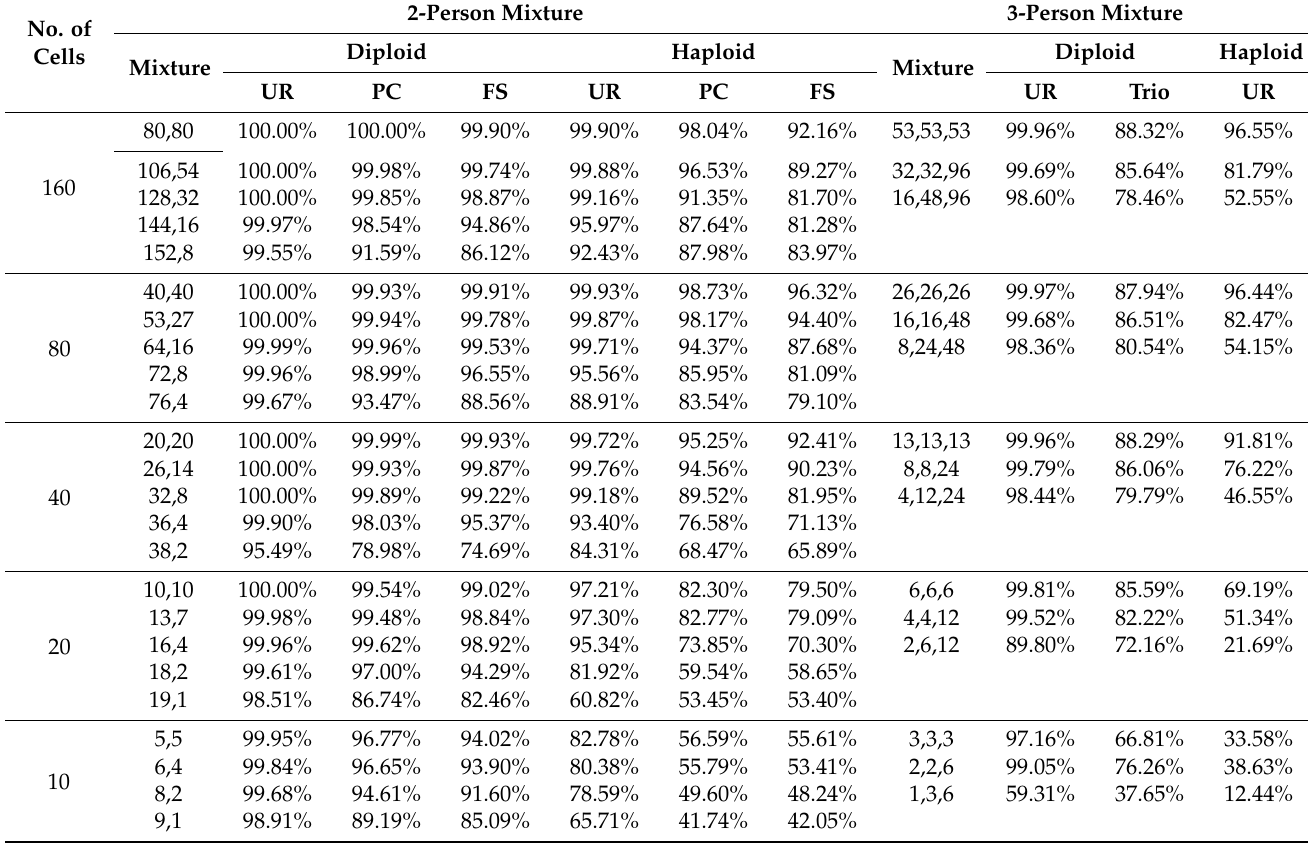
Table 1. Accuracies of estimating the NOC with the EM algorithm and Silhouettes method for the various mixture scenarios. UR = unrelated, PC = parent-child, and FS = full-sibling. D = 0.2; e = 0.01; 10,000 simulations for each mixture scenario. No.